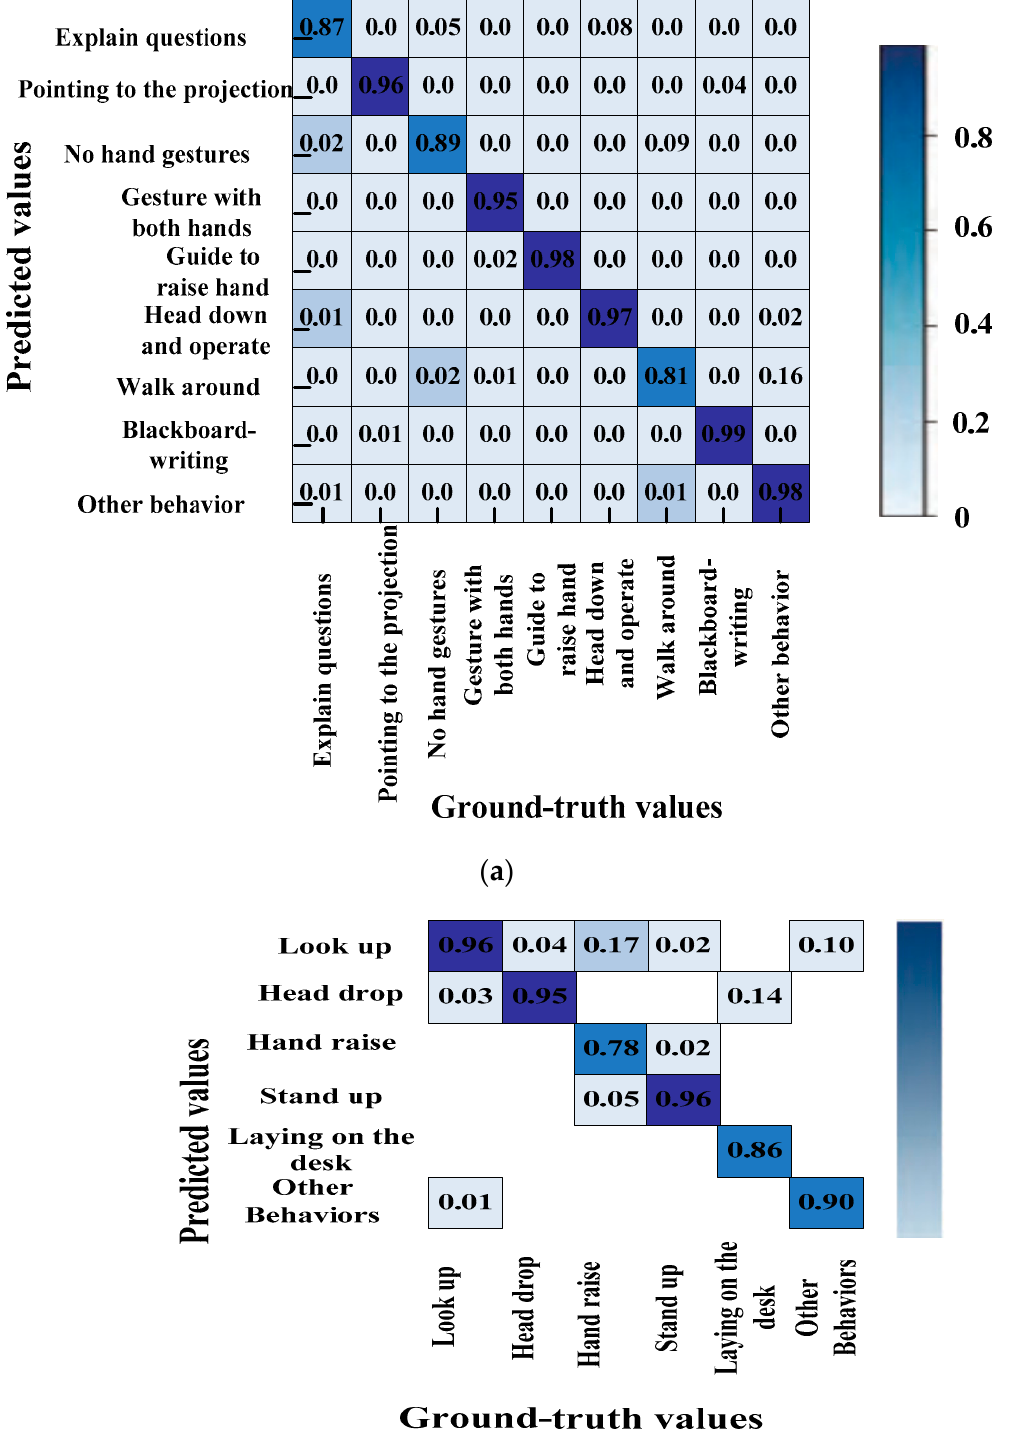
Table 2. Evaluation results on the teacher dataset.